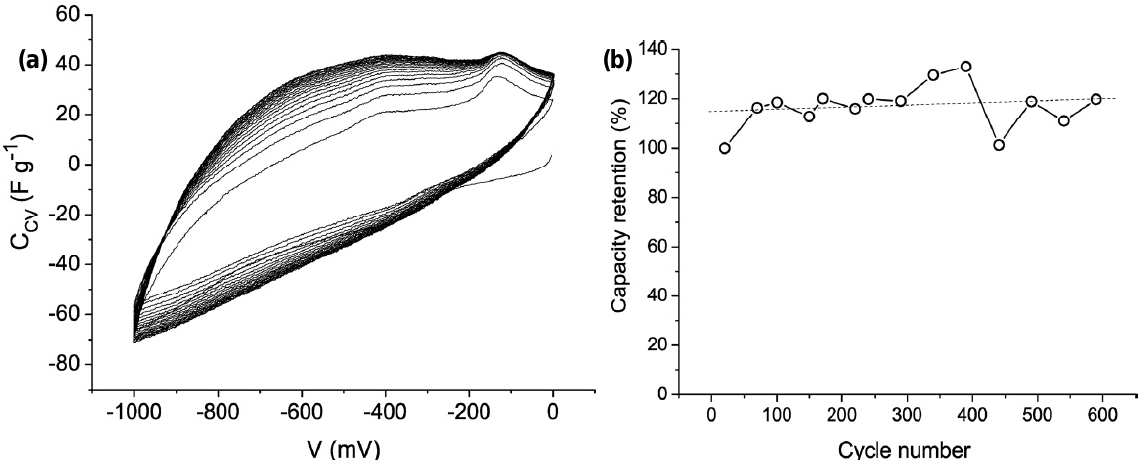
Fig. 8. Cyclic voltammetry curves for the first 20 cycles (a) and capacitance retention as a function of cycle number (b) for monolithic activated carbon bioC_15. The dashed line is only included as a guide to the eye. (1 M KOH